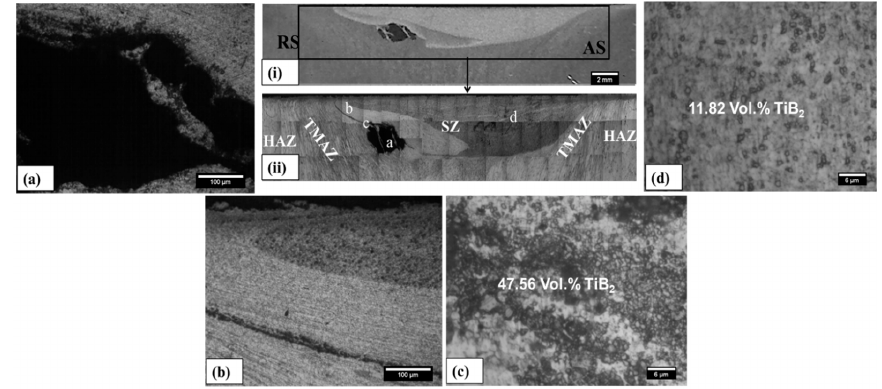
Figure 11. ( i ) Macro-image of cross-section of Sample 5. ( ii ) Microstructure of cross-section of the rectangle in macro-image showing: ( a ) agglomerated region; ( b ) RS reinforced zone interface; ( c ) mixed region; and ( d ) dispersed region.